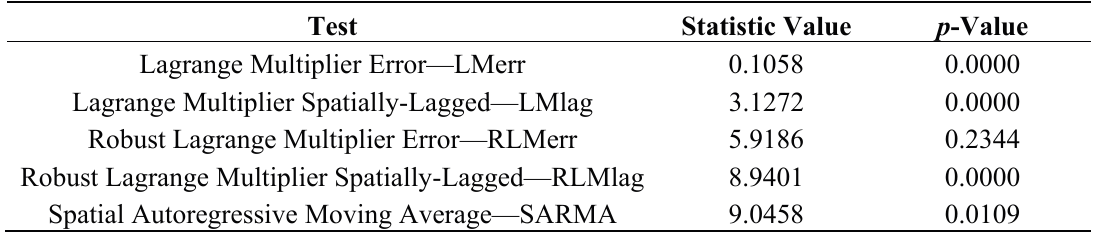
Table 4. Lagrange Multiplier Test (LMT): Rome, total VRU traffic accidents.